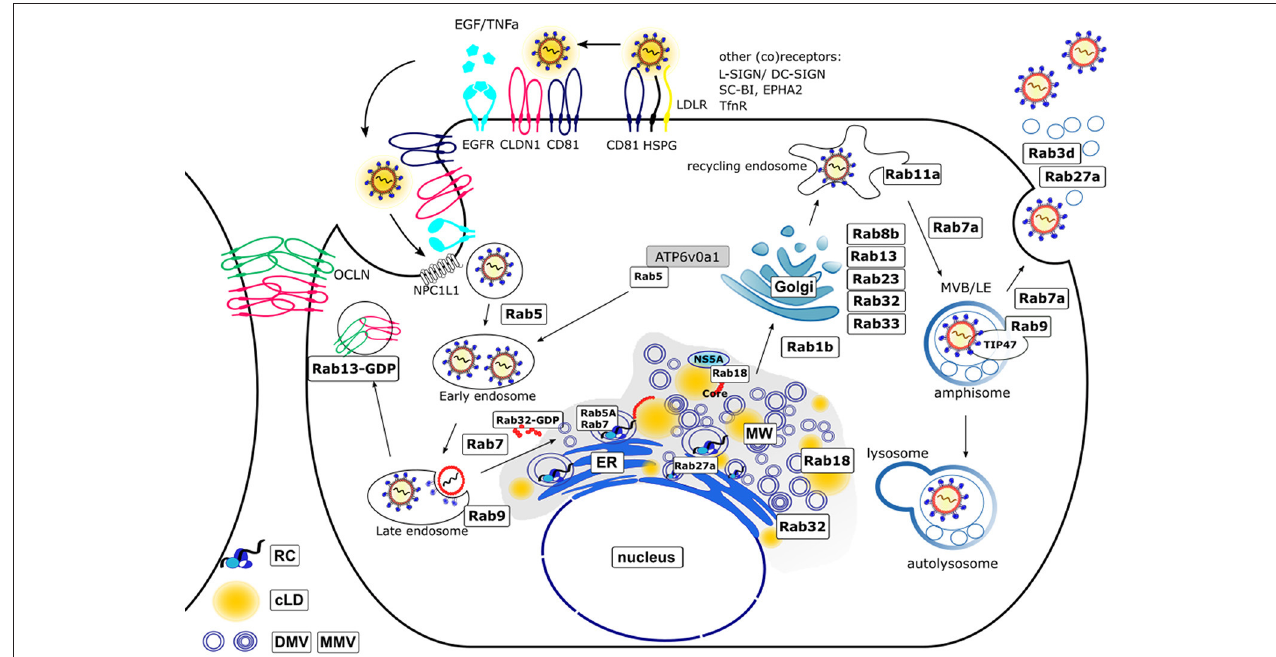
FIGURE 1 | Schematic model of the HCV life cycle and involved Rab proteins. The entry of the HCV lipoviroparticles (LVPs) occurs in a coordinated way by binding of the LVPs to specific (co)receptors. The LVPs initially bind to heparan sulfate proteoglycans (HSPG) and the low density-lipoprotein receptor (LDLR) resulting in a local accumulation. After binding to scavenger receptor class B member 1 (SR-BI) a conformational change of E2 enables the binding to CD81 which then activates signal transduction via the epidermal growth factor receptor (EGFR). The LVP-loaded CD81 migrates by lateral diffusion to the tight junctions (TJ) where interaction with the TJ proteins occluding (OCLN) and claudin-1 (CLDN1) takes place and the LVPs are internalized via clathrin mediated endocytosis [Additional (co)receptors are: L-SIGN, DC-SIGN, ephidrin type A receptor 2 (EPHA2), Niemann-Pick C1-like receptor 1 (NPC1L1) and transferrin receptor (TnfR)]. After maturation of early endosomes to late endosomes the release of the viral nucleocapsid into the cytoplasm occurs in a pH-dependent manner. Hereby, Rab5A is required for acidification as it transports the vacuolar (H + )-ATPase (V-ATPase) ATP6v0a1 from the trans-Golgi (TGN) network toward endocytotic vesicles. The trafficking from early to